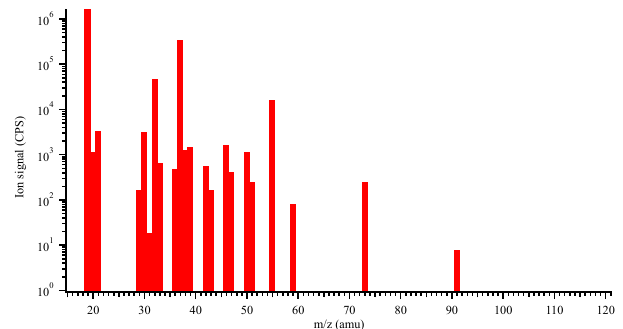
Figure 2. A typical mass spectrum produced by the PTR-ID-CIMS in the